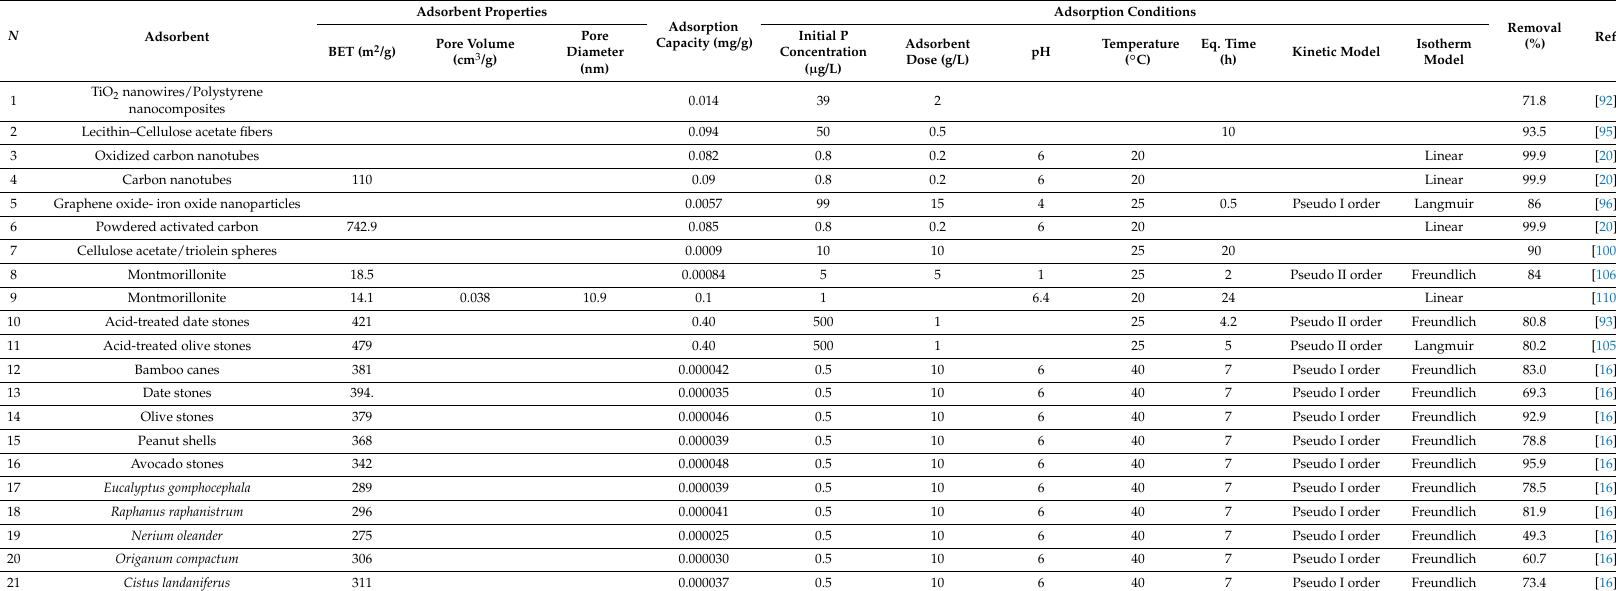
Table 15. Nanofibrous adsorbent properties and adsorption conditions for the removal of Endrin.